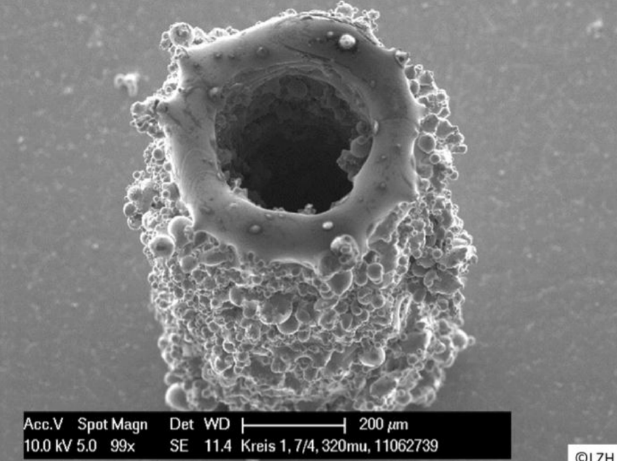
Figure 28 . An SLM-fabricated micro-needle for drug delivery applications, where the needle was constructed from 316L stainless steel powder, with a length of 550 μ m and an interior aperture constructed from 316L stainless steel powder, with a length of 550 µ m and an interior aperture measuring 160 μ m across [145]. measuring 160 µ m across